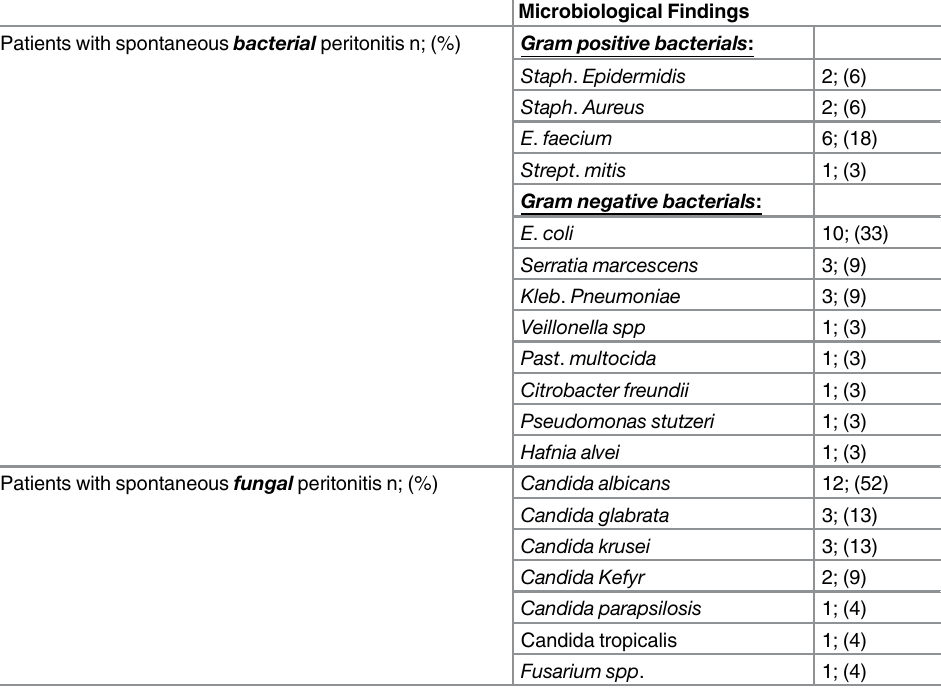
Microbiological Findings